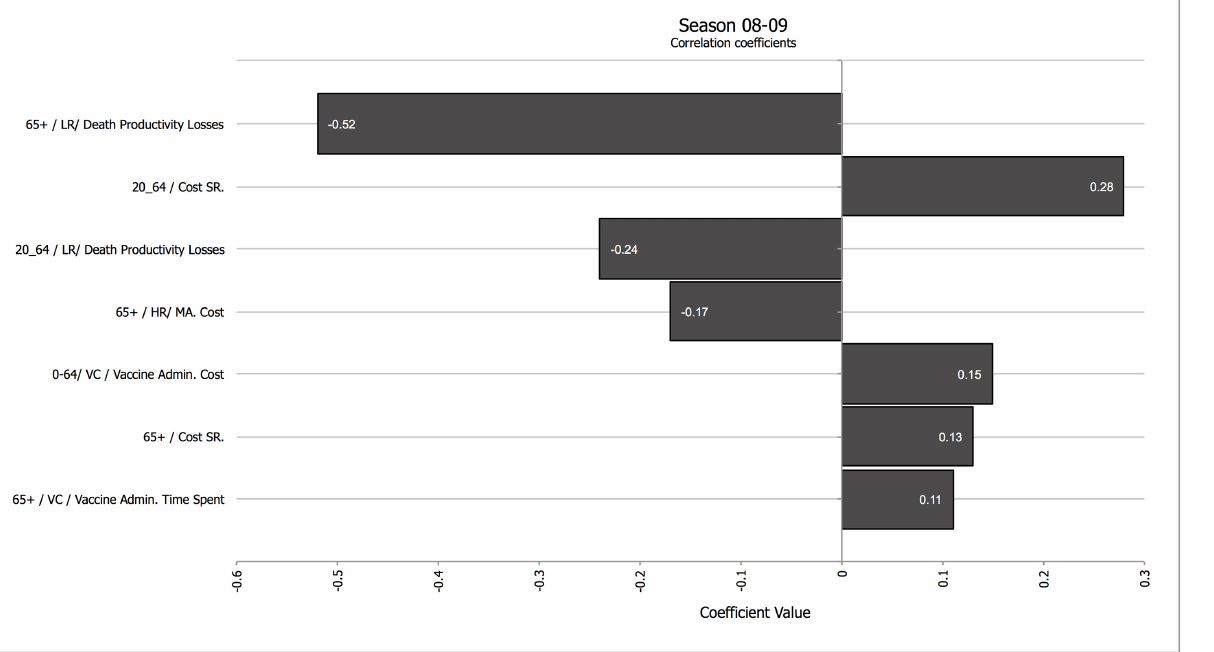
Fig 4. Tornado coefficient for Net Costs (all age cohorts, and including productivity losses, societal perspective) for season 08 – 09. Correlation coefficients in the horizontal axis. Abbreviations: Cost SR. – Cost of Systemic Reaction; HR — High Risk; LR: Low Risk; MA — Medically Attended; VAC — Vaccine Administration. When applicable, the numbers in the left of the factor represent the age cohort the costs refer to. Components with correlation values < 0.1 were not